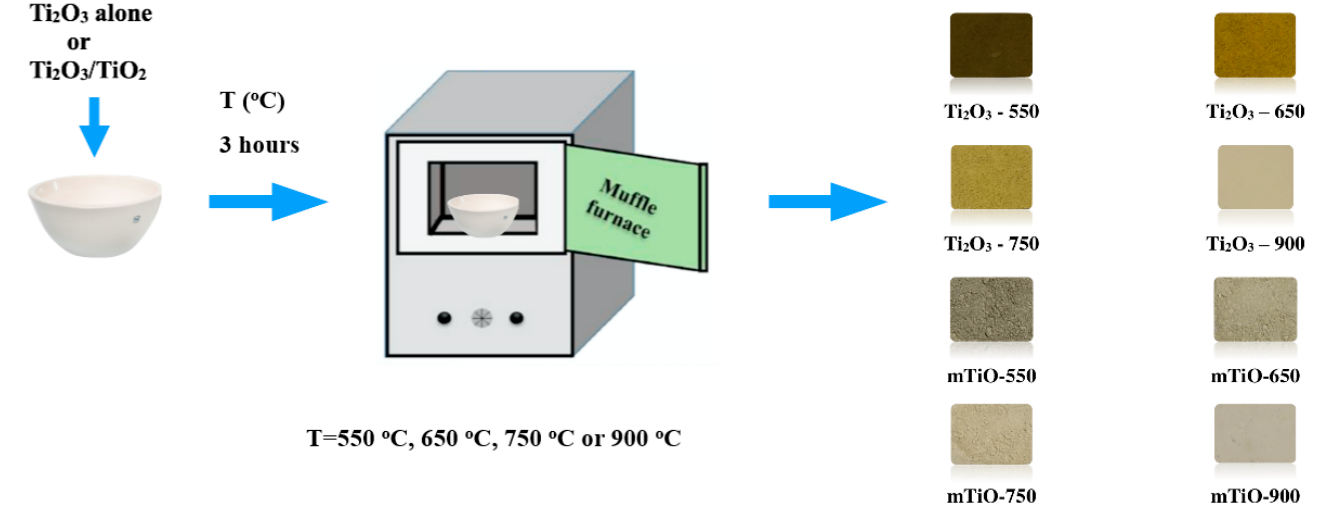
Figure 18. Preparation of thermally treated Ti 2 O 3 and mTiO catalysts.